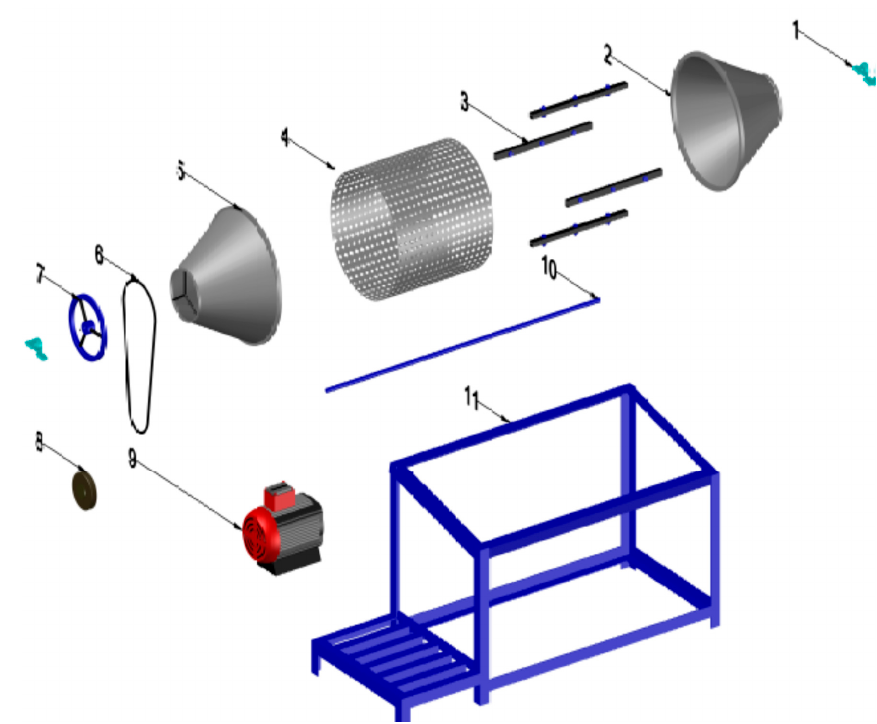
Figure 3. General machine description (1-handle; 2-right drum head; 3-rod; 4-wire gauze; 5—left drum head; 6-v-belt; 7- pulley; 8-motor seal; 9-electric motor; 10-shaft, 11- frame).